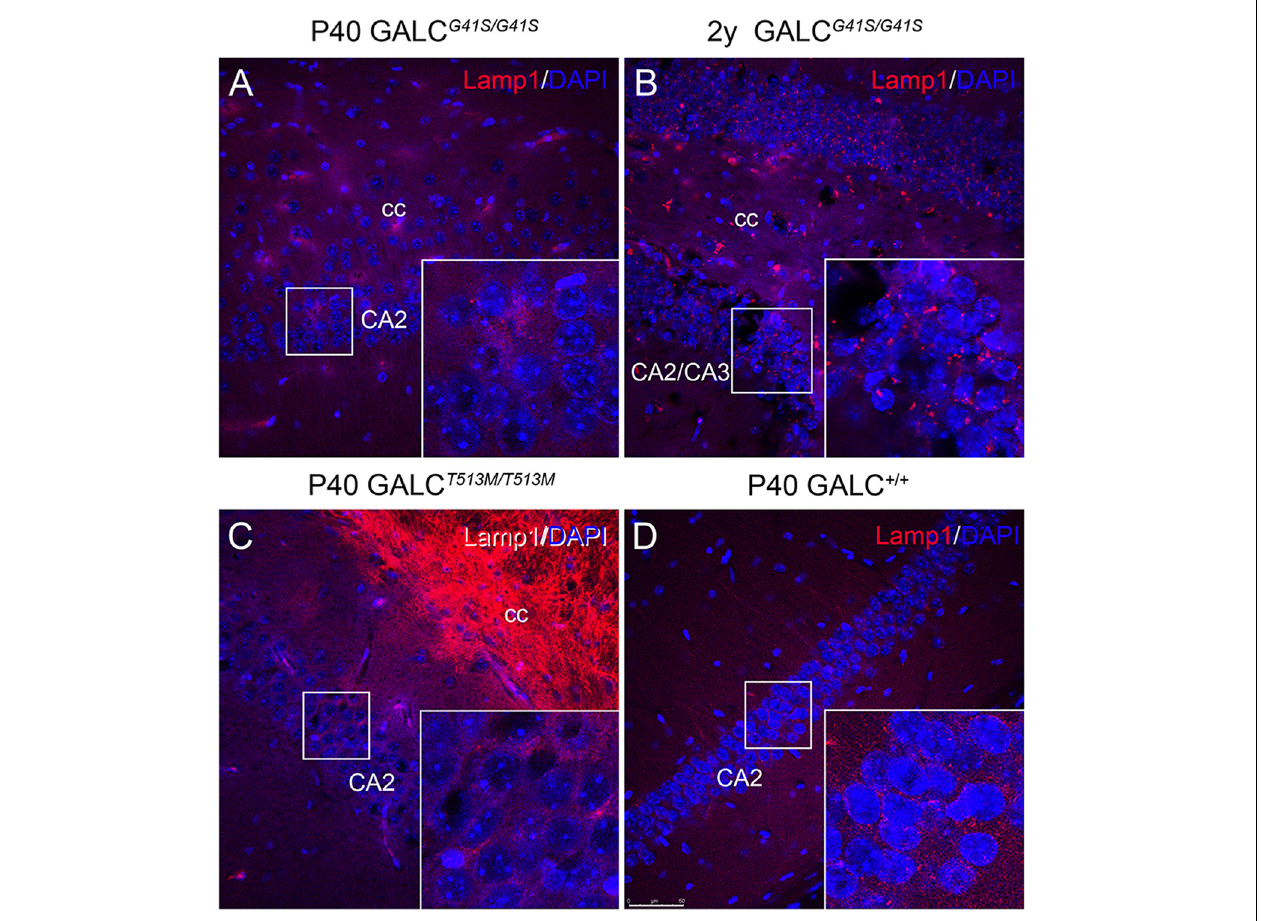
FIGURE 11 | Increased expression of LAMP-1 in aged GALC G 41 S / G 41 S neurons. Confocal microscopy after immunohistochemistry using anti-LAMP-1 antibodies (in red) was used to evaluated lysosomal responses in hippocampal neurons. Lamp1 expression was not significantly affected in either P40 GALC G 41 S / G 41 S (A) or P40 GALC T 513 M / T 513 M (C) neurons. However, larger Lamp1+ puncta were detected in 2 year-old GALC G 41 S / G 41 S neurons (B) , in comparison to control levels (D) . Blue: DAPI. Bar = 50 µ